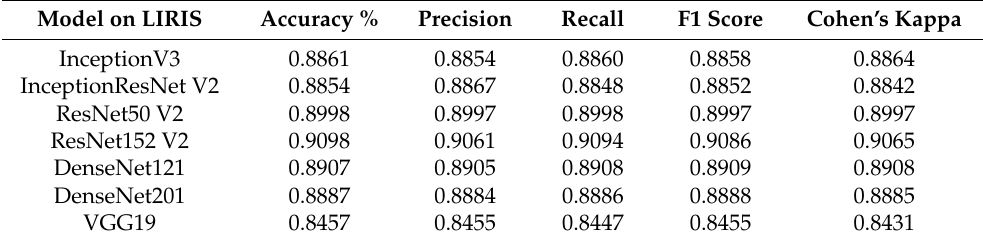
Table 5. Comparison of Model wise metrics on Authors’